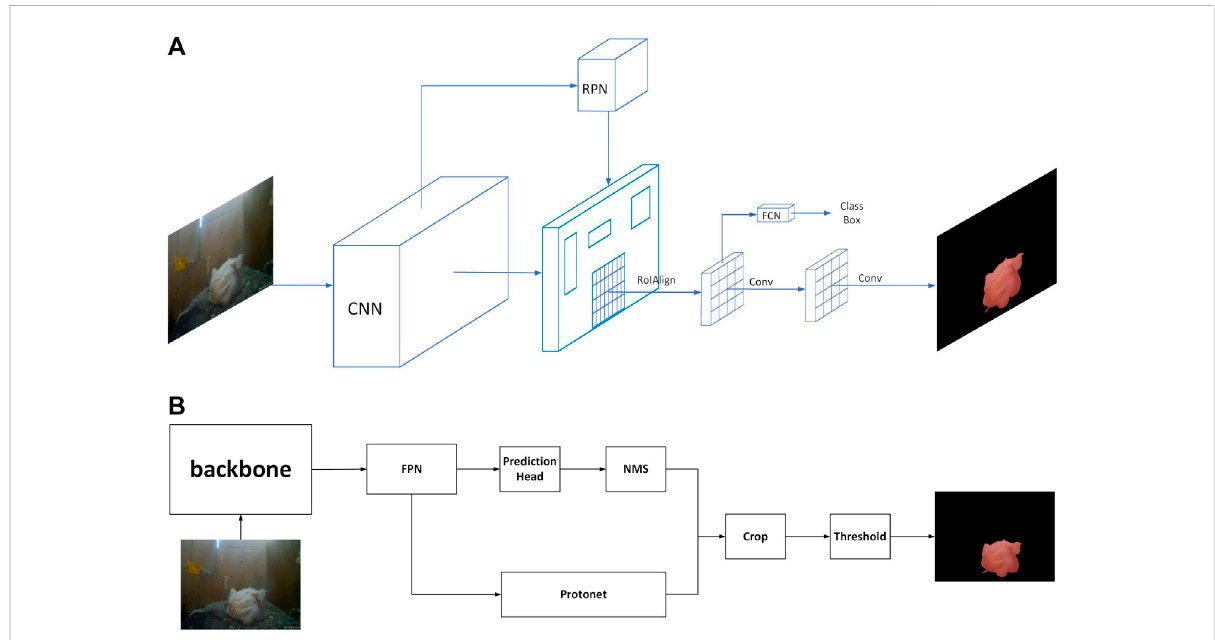
FIGURE 2 Semantic segmentation models structure. (A) Mask R-CNN framework diagram. (B) YOLACT framework